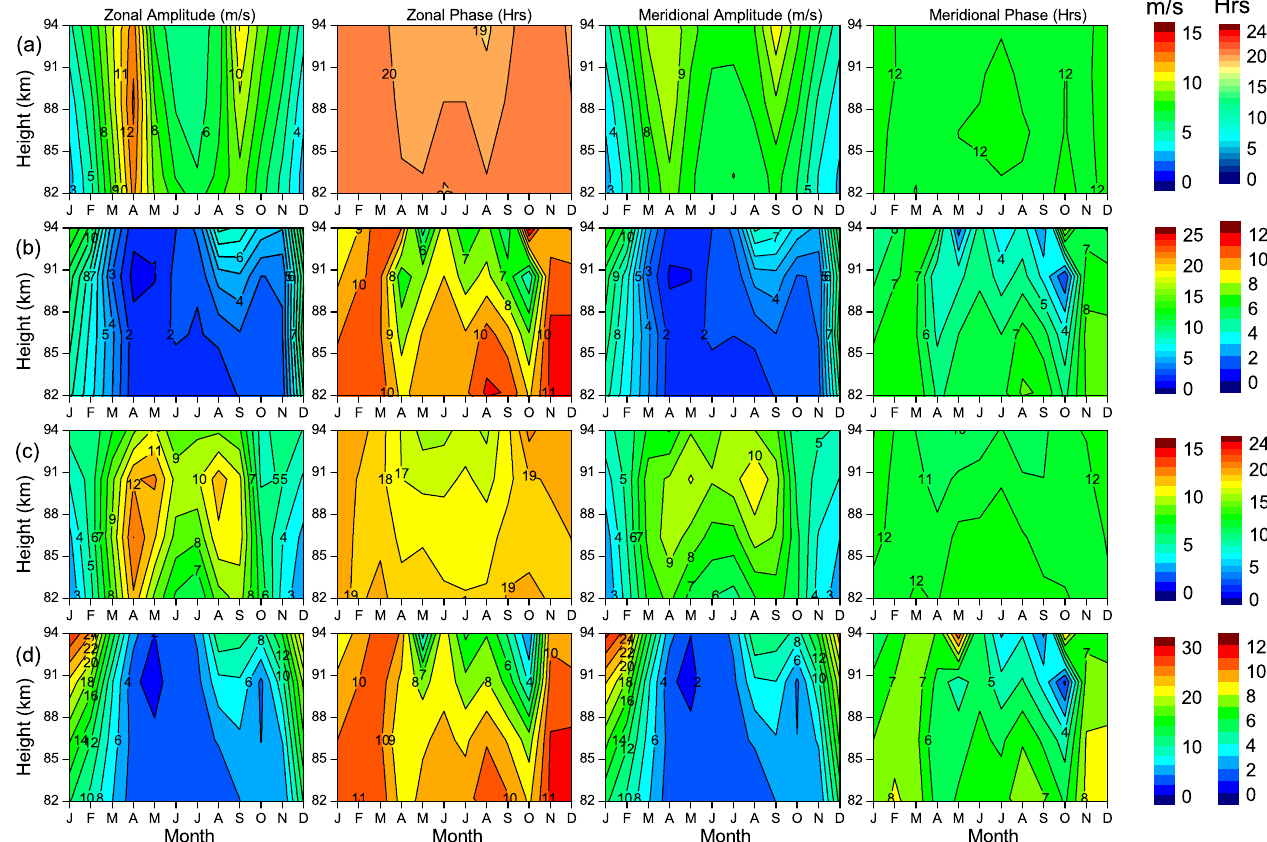
Fig. 9. Monthly variations of GSWM 00 predictions of zonal amplitude, phase, meridional amplitude and phase (a) for diurnal tide over 75 ◦ N (b) for semidiurnal diurnal tide over 75 ◦ N. (c) and (d) are same as (a) and (b), but over 63 ◦ N. Note that the first color bar is meant for amplitude and the second color bar is meant for